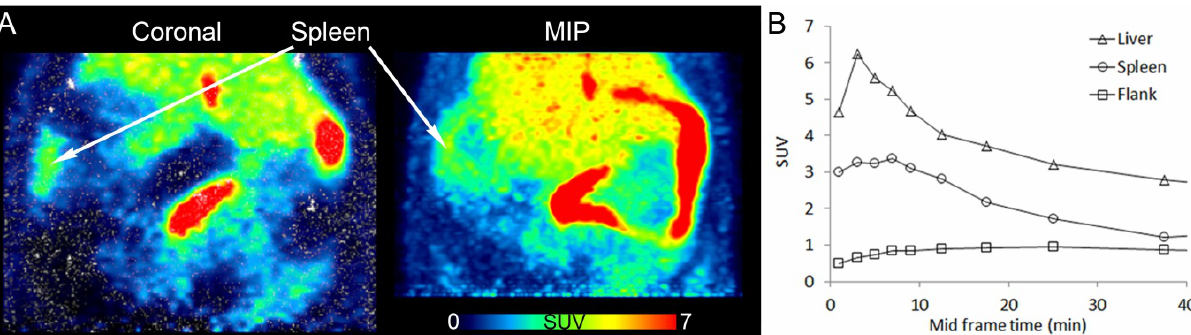
Figure 3. PET/CT images of [ 11 C]KP23 in the spleen-liver region in rat. ( A ) Coronal section and maximal intensity projection (MIP) averaged from 6 to 15 min p.i. ( B ) TACs of [ 11 C]KP23 in spleen, liver and flank.